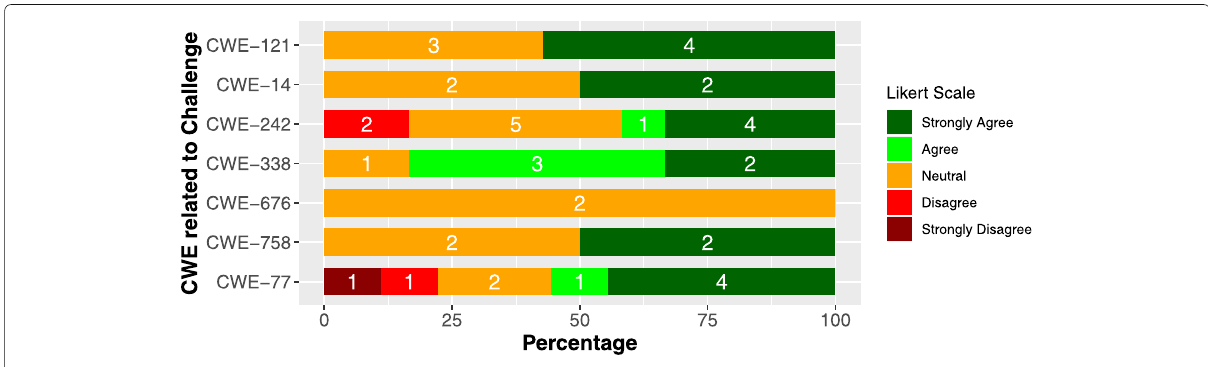
Fig. 13 Evaluation of Challenges in Sifu Platform - Survey S 1 , Q2